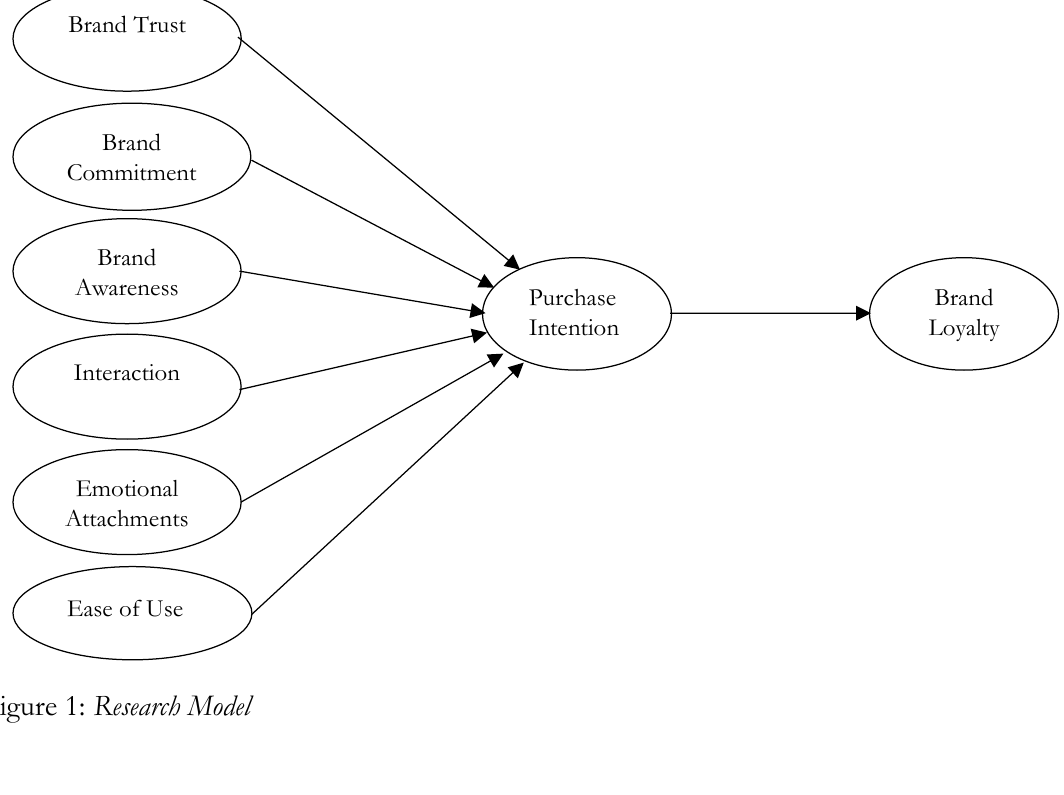
Figure 1: Research